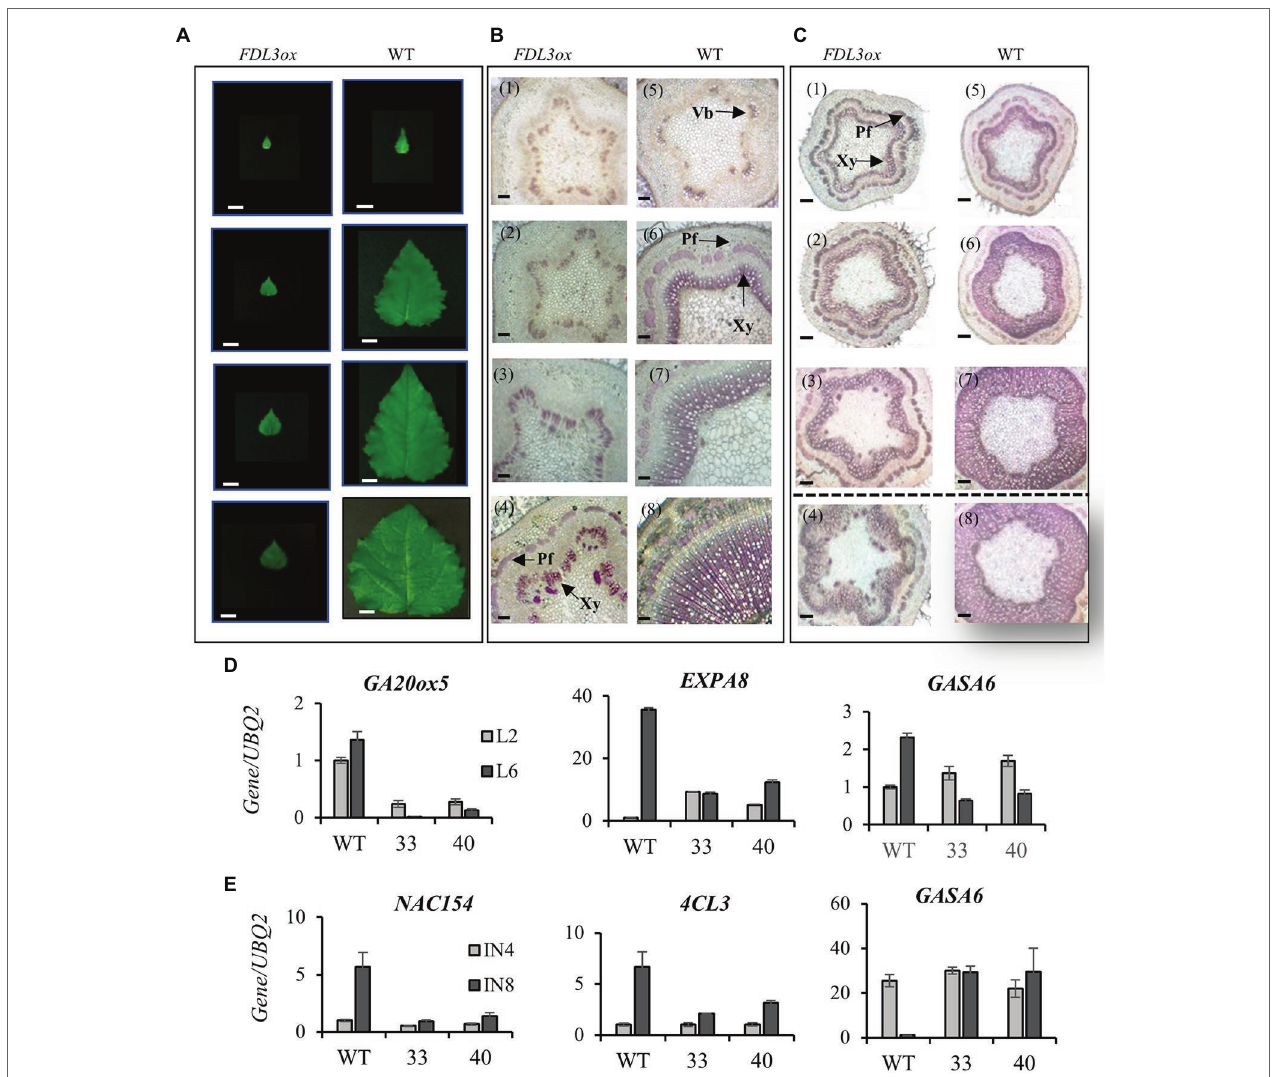
FIGURE 5 | Overexpression of FDL3 synchronously inhibits leaf expansion and the transition to secondary growth in long days (LDs), but secondary growth is restored in short days (SDs). (A–C) Both FDL3ox and WT plants were grown in a LD greenhouse for 6 months and subsequently transferred to a SD growth chamber for 8 weeks. Leaves were counted from top to bottom according to leaf plastochron index (LPI). Internode (IN) number refers to the internode beneath the corresponding LPI. All panels show from top to bottom LPI2, LPI4, LPI6, and LPI10 leaf or corresponding IN. (A) Extremely slow growth of FDL3ox leaves compared to WT in LDs. Scale bars = 2 cm. (B) Severely inhibited secondary growth in FDL3ox plants (B1–4) compared to progressive transition to secondary growth in WT (B5–8) in LDs. (C) Secondary growth in IN2, IN4, and IN6 formed after exposure to SDs (images above dotted line) in FDL3ox (C1–3) and WT (C5–7) plants. Note that FDL3ox INs 4 and 6 (C2,3) now resemble the same INs of WT plants grown in LDs (B6,7) . In contrast, IN10 (C4) formed in LDs before SD treatment remained underdeveloped in FDL3ox . After exposure to SDs, WT plants ceased elongation growth, IN2 transitioned to secondary growth (C5) and substantial secondary xylem accumulated in IN4 and IN6 of WT (C6,7) . Transverse sections were 60 μ m thick, Scale bars = 100 μ m. Vb, vascular bundles; Pf, phloem fiber; and Xy, xylem. (D,E) Comparative expression analysis of leaf and stem developmental marker genes in WT and two events of FDL3ox (33 and 40) grown in LDs. Relative expression in LPI2 and LPI6 leaves (D) and in internodes IN4 and IN8 (E) . Expression was normalized against reference gene ubiquitin gene ( UBQ2